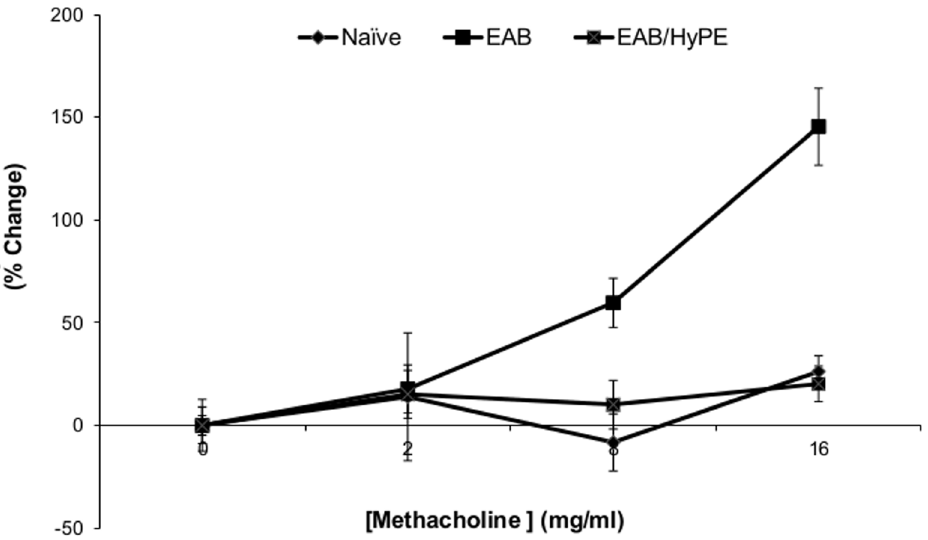
Figure 1. Airway resistance of EAB mice following methacholine challenge. Mice with OVA-induced EAB (EAB-Mice), with/without treatment with sPLA 2 inhibitor (EAB and EAB/HyPE, respectively), were challenged with methacholine. Airway resistance was determined as described in Methods. Data are mean 6 SEM for 8 mice. *, P , 0.01 for the highest dose.